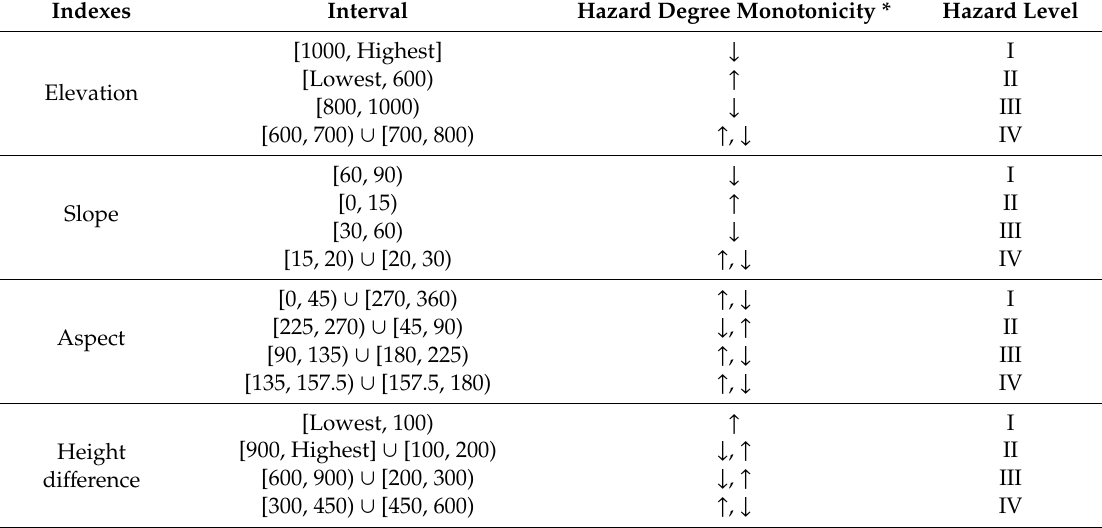
Figure 6. Frequency distribution of historical landslide in each evaluation indicator: ( a ) elevation, ( b ) slope, ( c ) aspect, ( d ) height difference, ( e ) topographic profile curvature (TPC), ( f ) NDVI, ( g ) AAR, and ( h ) distance from the fault. Table 3. Grade of landslide hazard corresponding to each interval.